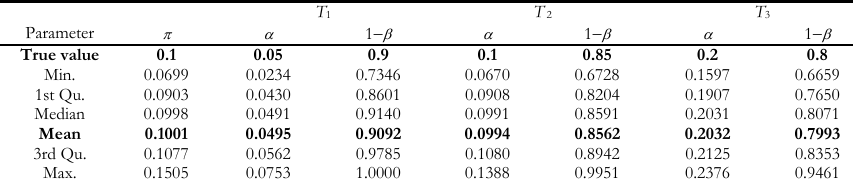
Simulation Results for illness incidence and specificity and sensitivity of three tests